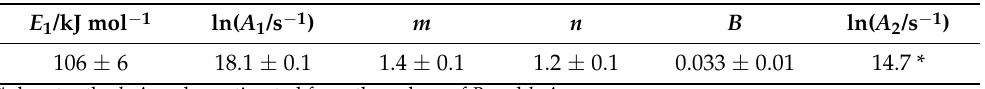
Table 1. Estimated kinetic parameters for polymerization of tricyanate ester 6 . E 1 /kJ mol − 1